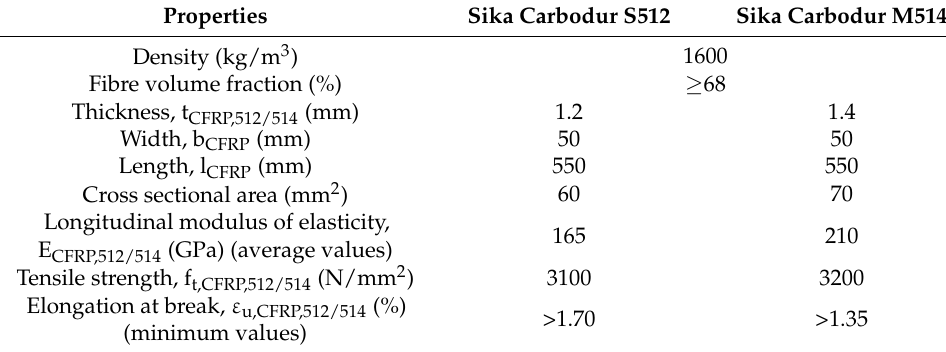
Table 2. Properties of the CFRP composite strips [18,19].